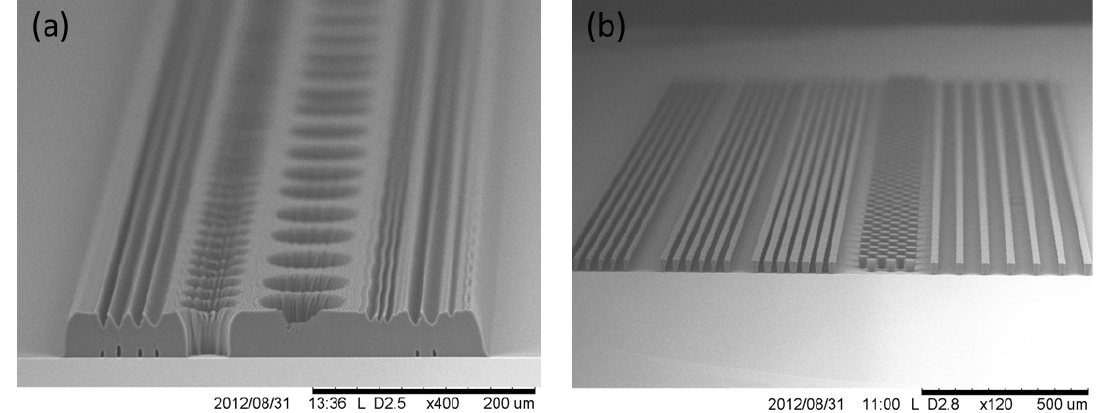
Figure 4. SEM (scanning electron microscope) images of ~50 µm thick (spinned at 2000 rpm) laser-patterned ORMOCOMP ® using 1 µm spot size and two different scan modes: ( a ) Stage scan with an estimated dose of ~10 J·cm −2 ; ( b ) Beam scan with an effective dose of 1.6 J·cm −2 .